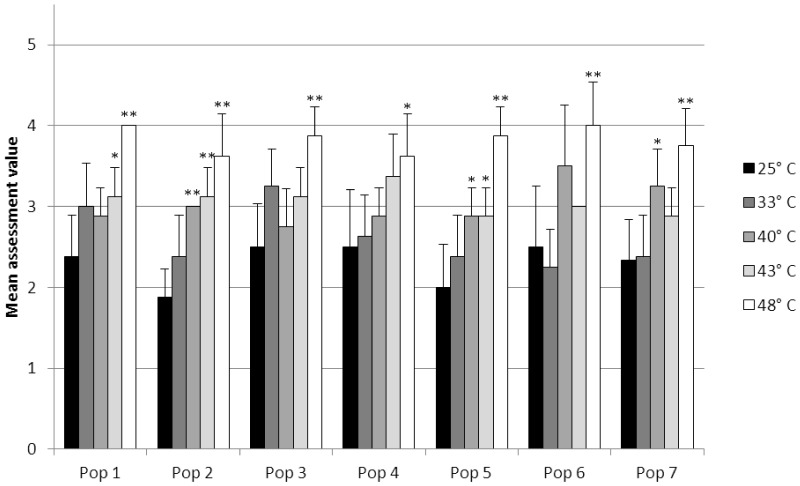
The structural condition of the hepatopancreatic tubules.Mean assessment values for each population at elevated temperature. Shown are means and SD; n = 8. Asterisks show significant differences of the respective exposure groups compared to the control at 25°C after Bonferroni correction: 0.0025<P≤0.0125: (*) and 0.00025<P≤0.0025 (**).